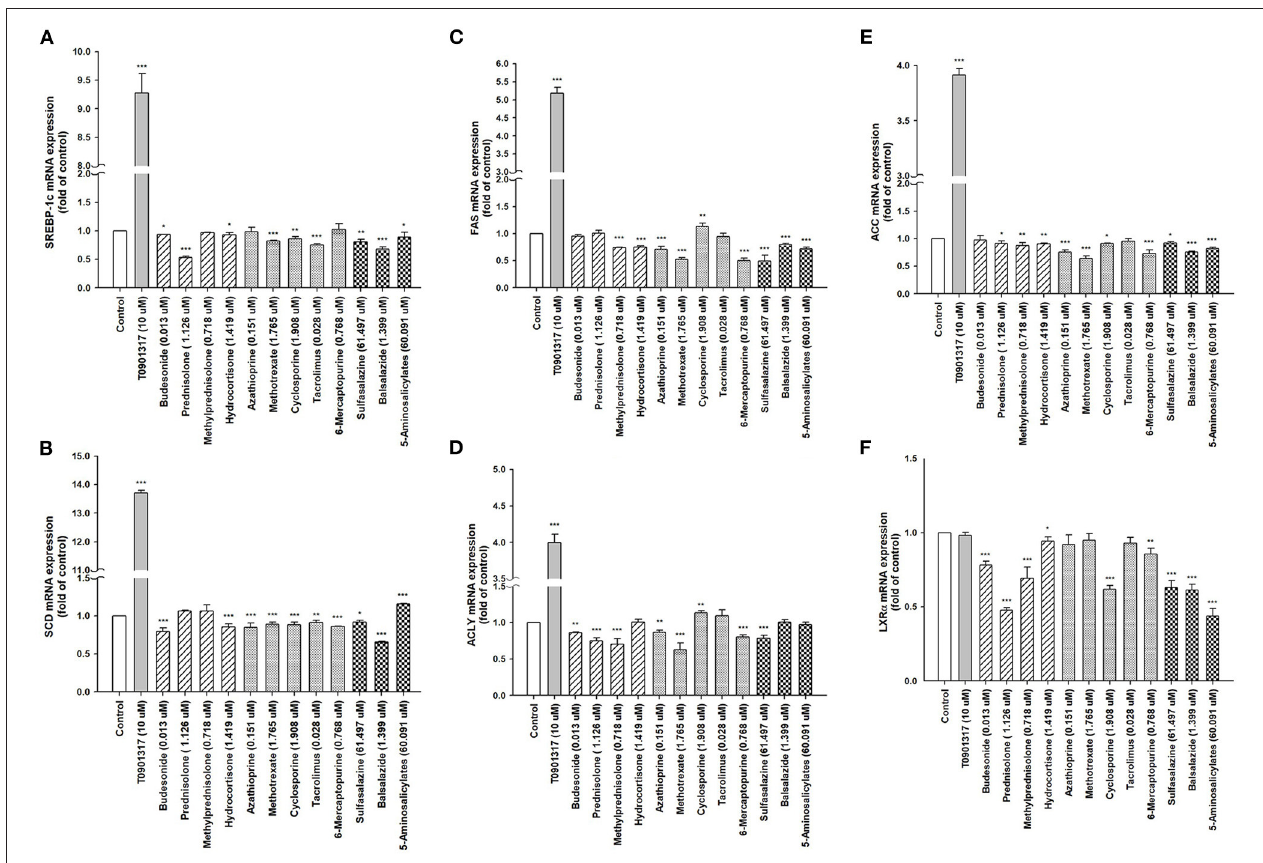
FIGURE 3 | Expression of hepatic lipid metabolism-related genes following treatment with T0901317 and IBD medications. Differentiated HepaRG cells were treated for 48h with T0901317 (10 µ M), corticosteroids (budesonide, prednisolone, methylprednisolone, and hydrocortisone), immunomodulators (azathioprine, methotrexate, cyclosporine, tacrolimus, and 6-mercaptopurine), and aminosalicylates (sulfasalazine, balsalazide, and 5-aminosalicylate). Following treatment, mRNA was extracted and the expression levels of (A) SREBP-1c ; (B) SCD ; (C) FAS ; (D) ACLY; (E) ACC ; and (F) LXR α were analyzed by qRT-PCR. Values were normalized to the expression of β -actin , with the levels of DMSO-treated cells set at 1. Results are expressed as the mean ± SE ( n = 3). * P < 0.05; ** P < 0.01; *** P < 0.001 compared with cells treated with